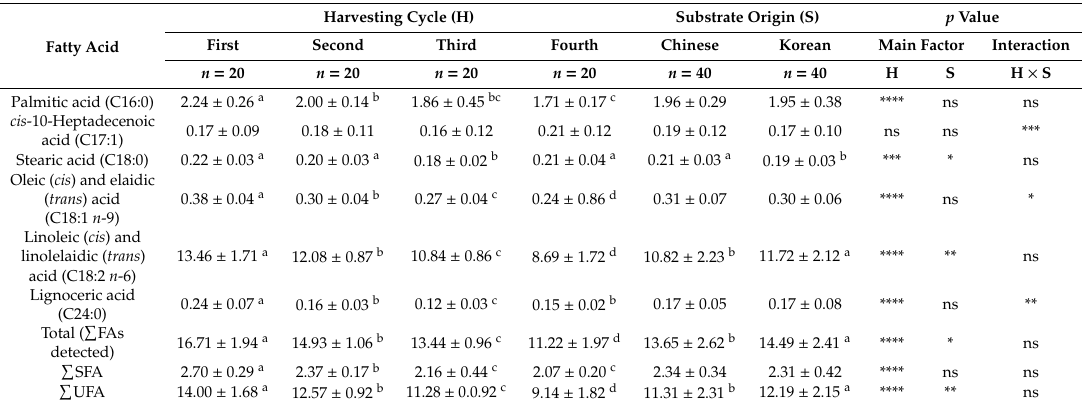
Data represent the mean values (±standard deviations) of FAs. a–d Values with different superscripts differ significantly with respect to the harvesting cycle or substrate origin. ns: not significant, * p < 0.05, ** p < 0.01, *** p < 0.001, **** p < 0.0001. Σ SFA: sum of SFAs and Σ UFA: sum of UFAs.